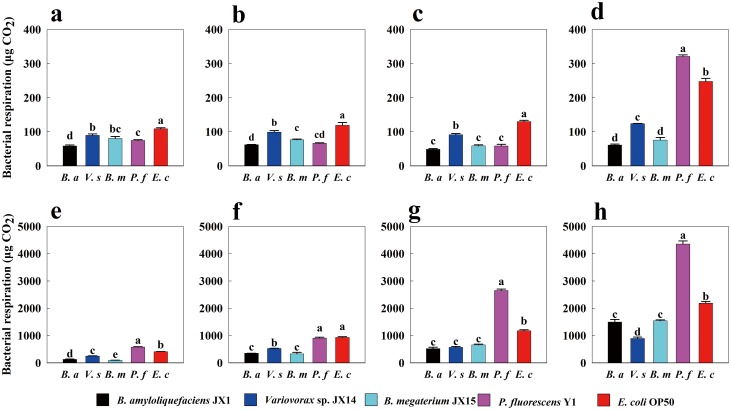
Bacterial respiration measured as CO2 released.Error bars represent standard errors, and letters over the error bars represent significant differences in bacterial respiration (p<0.05). a, b, c, d, e, f, g, and h represent 1, 2, 4, 8, 12, 24, 36, and 48 hours, respectively. The ordinate of Fig 4a–4d differs from the ordinate of Fig 4e–4h.